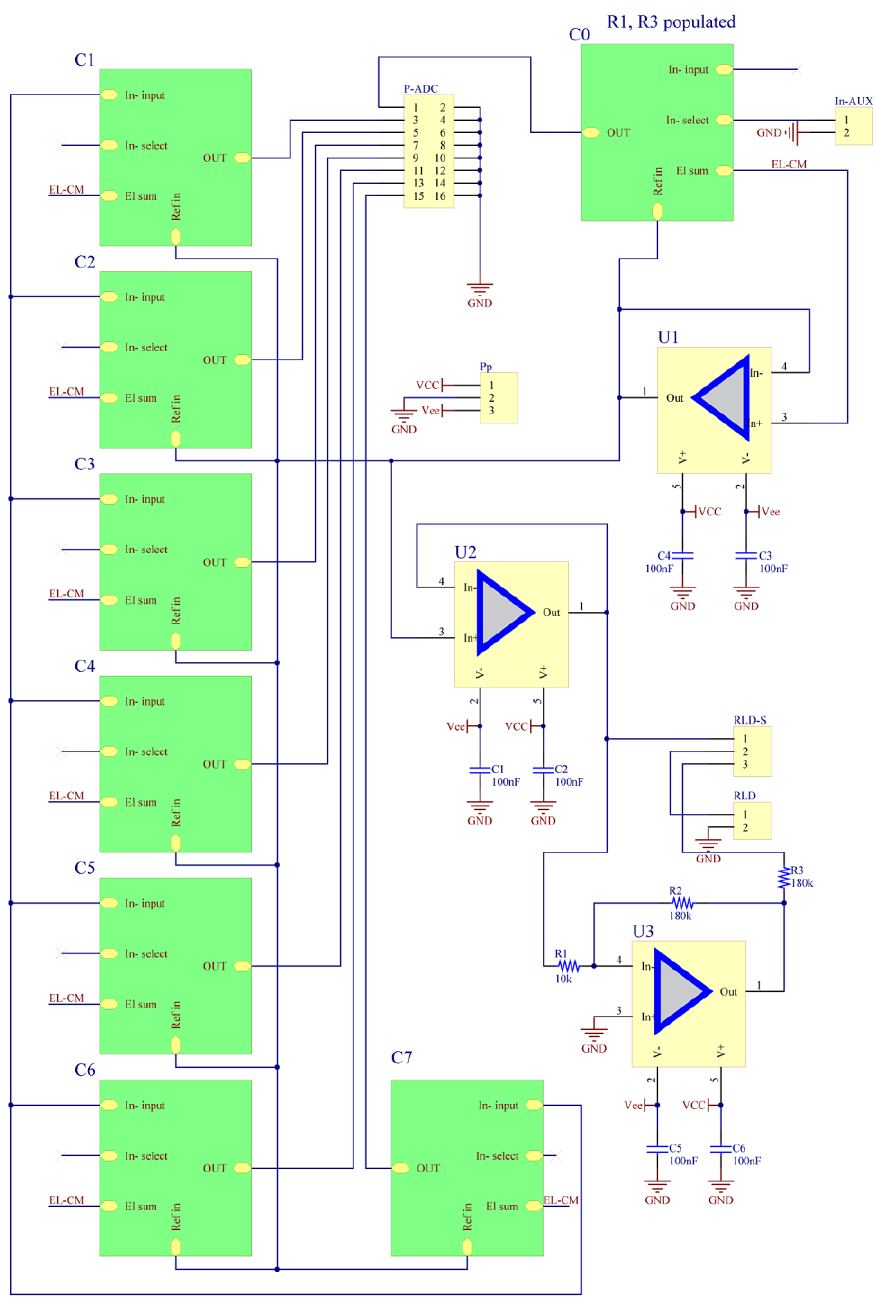
Figure 3. Complete 8-channel design (screen capture from Altium Designer).